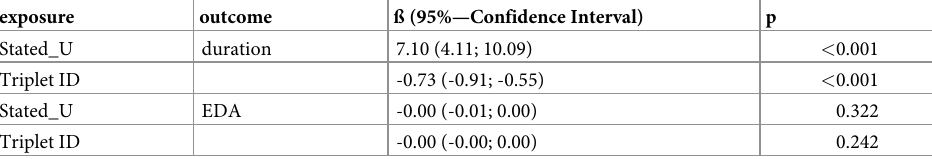
Table 11. Associations of Stated_U with duration and EDA. Associations were analyzed by mixed models with ran- dom intercept.